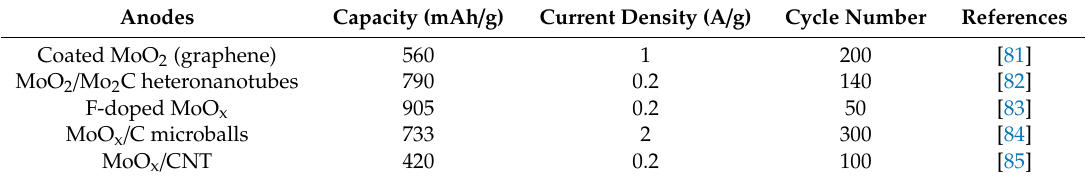
Table 3. Available literature reports on the use of MoO x materials in electrochemical